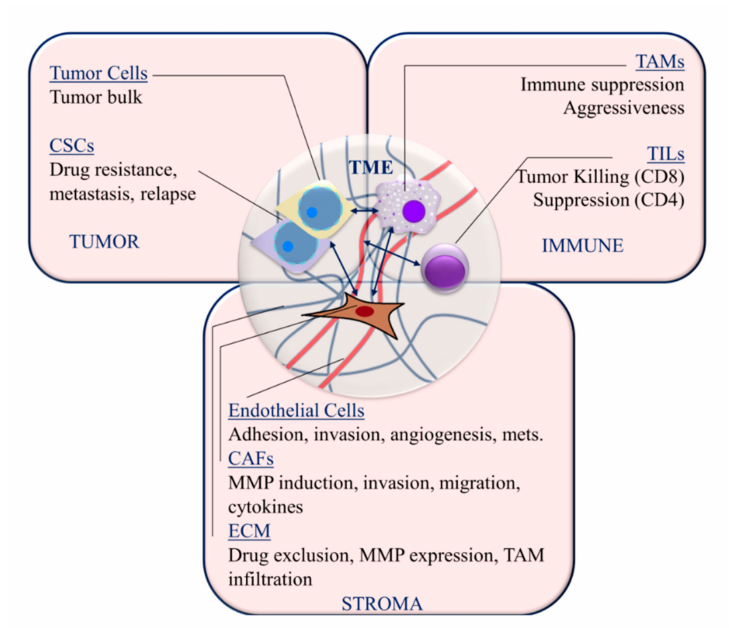
Figure 2. Targetable TNBC microenvironment components and interactions. Cancer stem cells (CSCs); tumor-infiltrating lymphocytes (TIL); tumor-associated macrophages (TAM); cancer-associated fibroblasts (CAFs); matrix metalloproteinases (MMPs); extracellular matrix (ECM); metastasis (mets); mesenchymal stem cells (MSCs). Arrows indicate interactions between cellular components of the tumor